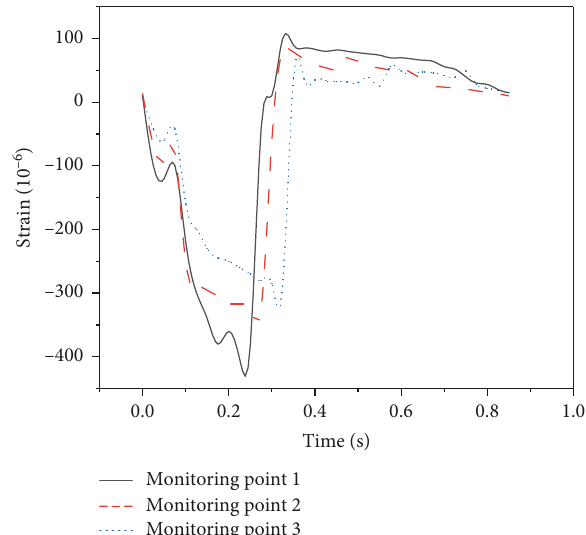
Figure 6: Time-history curves of the strain without confining